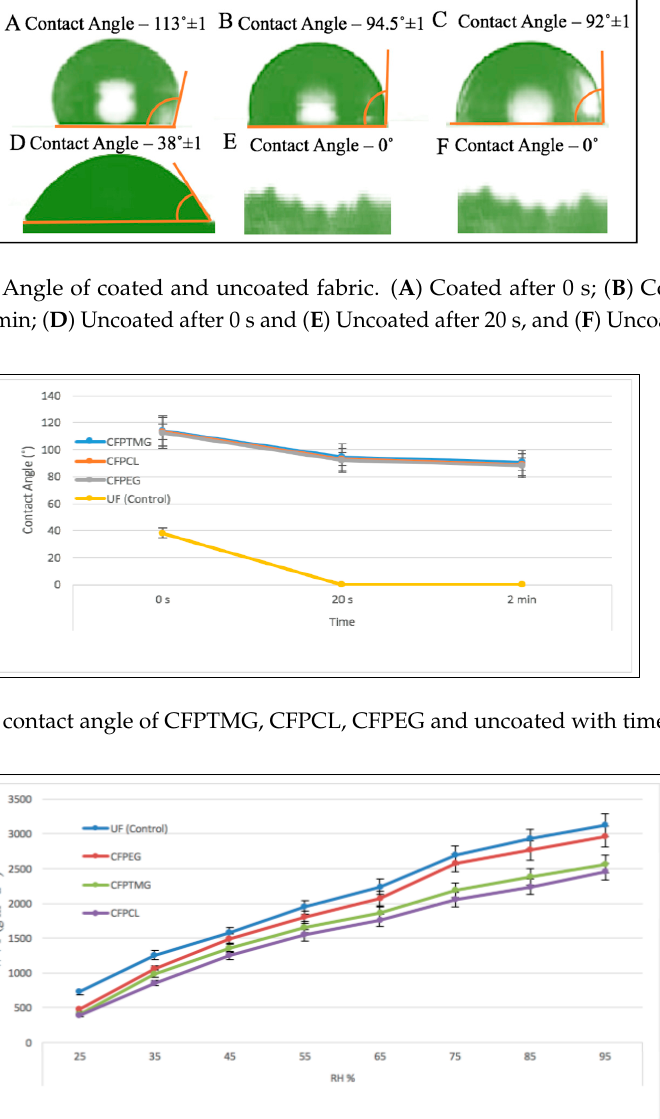
Figure 4. Contact Angle of coated and uncoated fabric. ( A ) Coated after 0 s; ( B ) Coated after 20 s; ( C ) Coated after 2 min; ( D ) Uncoated after 0 s and ( E ) Uncoated after 20 s, and ( F ) Uncoated after 2 min.